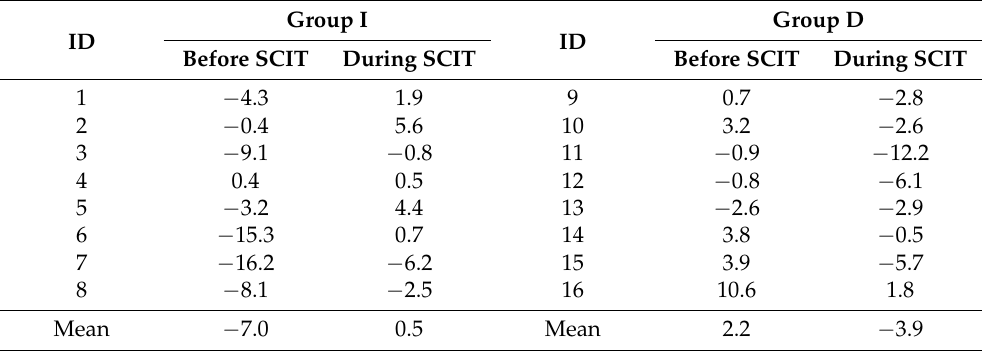
Figure 1. Representative lung function trajectories. MEF50% predicted values during the observation period are plotted (polygonal lines), and linear regression lines before and during SCIT are depicted in representative patients (#1 and #9 in Table 1, respectively) in Group I and Group D. Table 2. Predicted annual change in